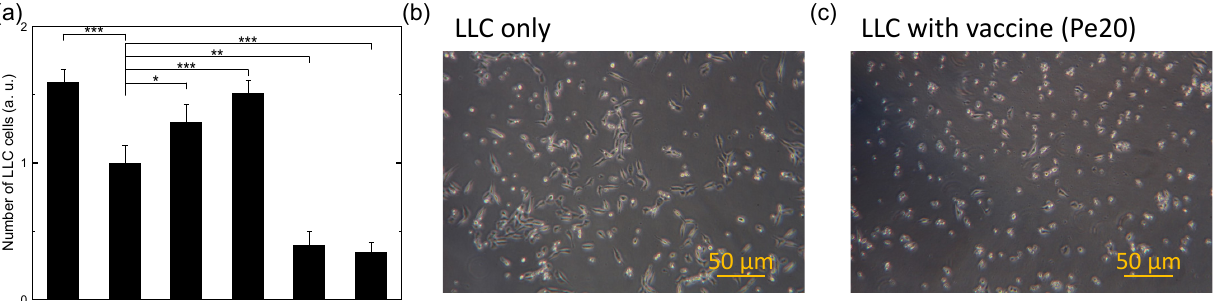
Figure 8. Numbers of viable LLC cells after being treated with various vaccines for 48 h in the absence of macrophages. ( a ) Comparison of various vaccines. JL: without the vaccine but with the macrophage; L: without the vaccine; He300: vaccine prepared using 300 µ M H 2 O 2 followed